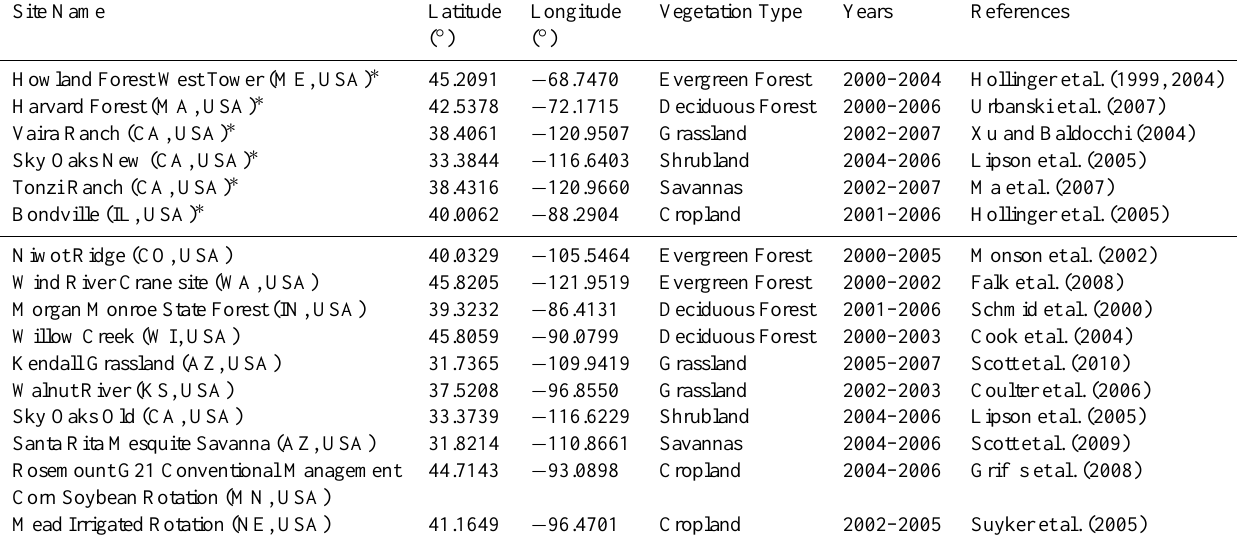
Table 1. Characteristics of AmeriFlux sites used in this study.